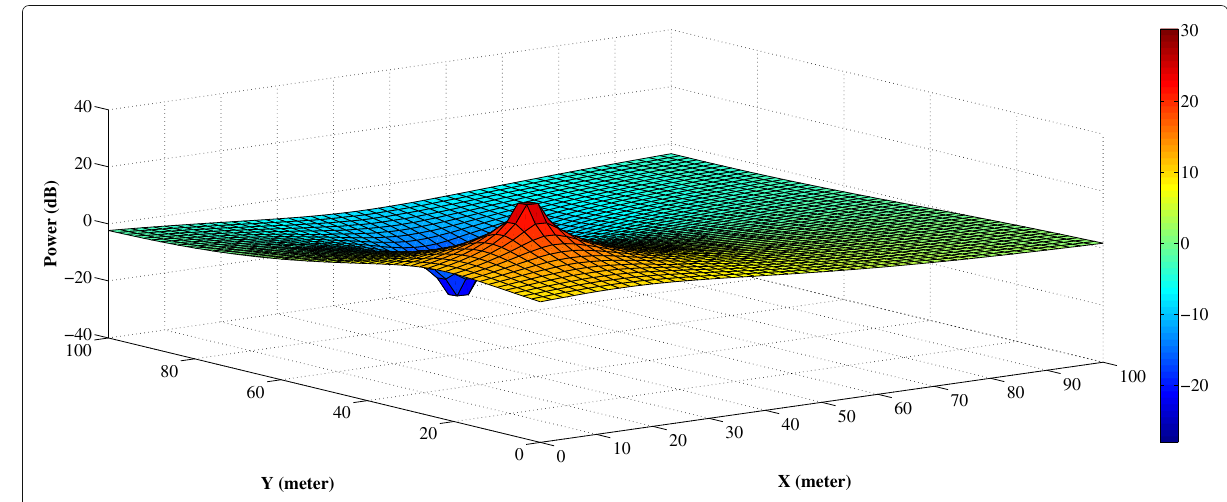
Fig. 6 RSSD distribution of AP12 with proposed RSSD-based filtering. P ( d 0 ) = 10 dB, α = 1.8, σ = 5.2 dB, d = 2 m, and t = 50